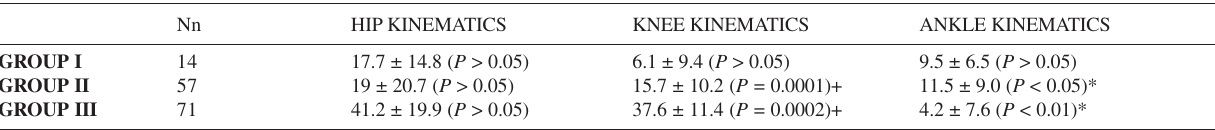
Table 2 - Mean value of the kinematic variables of hip, knee and ankle joints of patients with cerebral palsy with and without a floor reaction ankle–foot